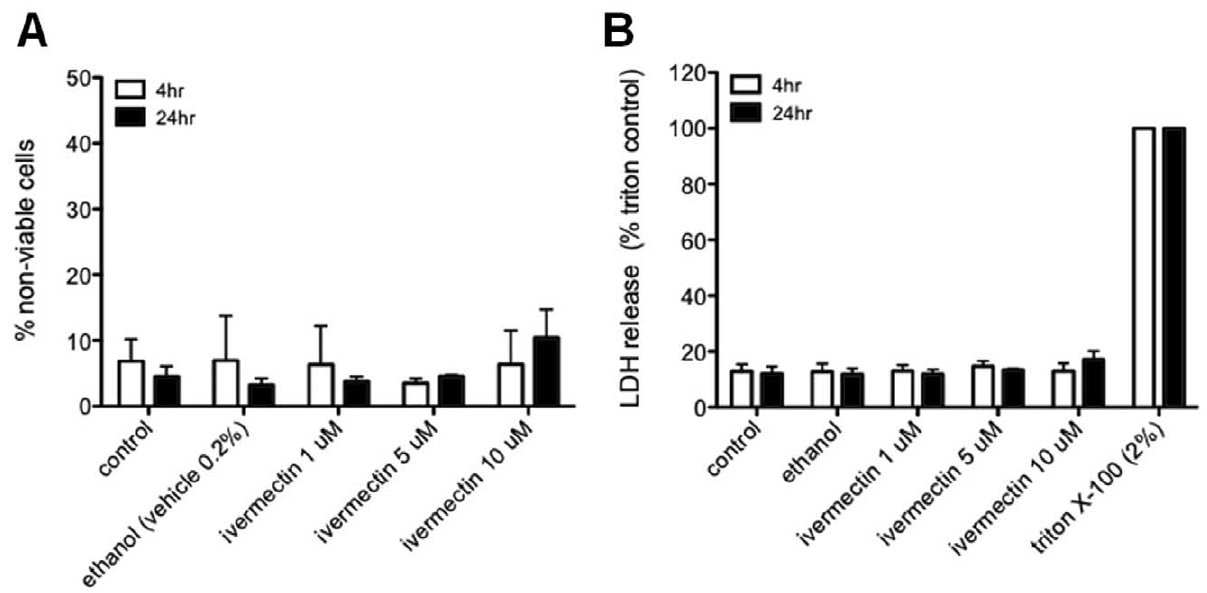
Figure 3. Ivermectin is not cytotoxic to epithelial cells. (A) HeLa cells were cultured in the presence of the indicated concentrations of ivermectin or vehicle (0.2% ethanol), supernatants were then centrifuged at 500 g for 5 minutes, and adherent cells were removed with trypsin/EDTA and gently recombined with supernatant pellets. Cell viability was determined by trypan blue exclusion, evaluated using a hemocytometer. (B) Supernatants from the cultures described in panel A, and from wells treated with 2% Triton X-100 30 minutes prior to collection time points, were combined and evaluated for LDH activity using a Roche Cytotoxicity Detection Kit per the manufacturer’s instructions. Shown are means plus standard deviations for 3 independent